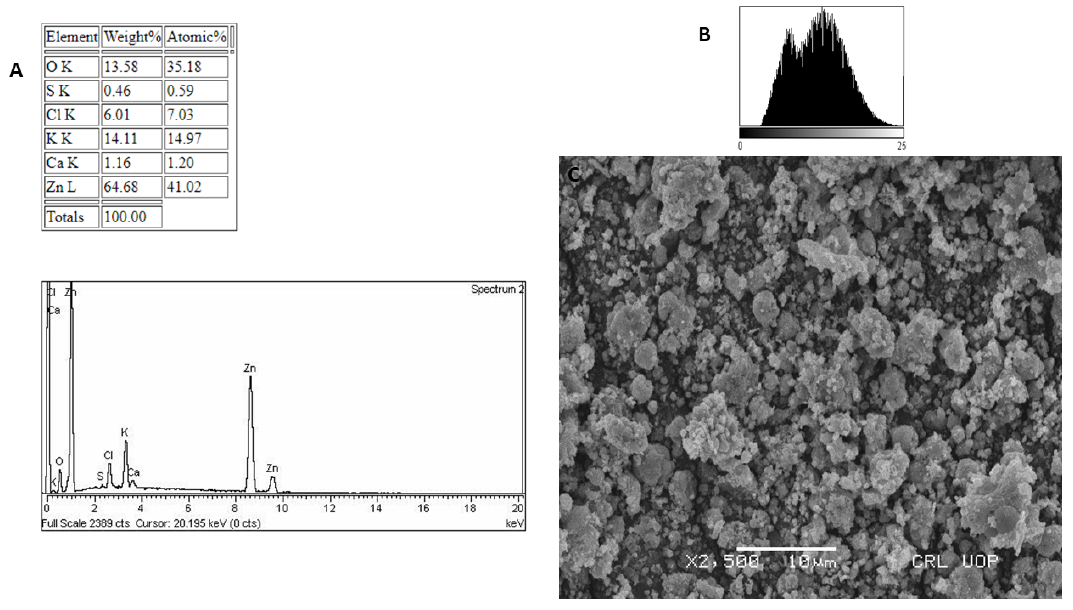
Figure 3. ( A ) EDX spectrograph. ( B ) Histogram. ( C ) SEM micrograph of Monotheca buxifolia synthesized ZnO-NPs. synthesized